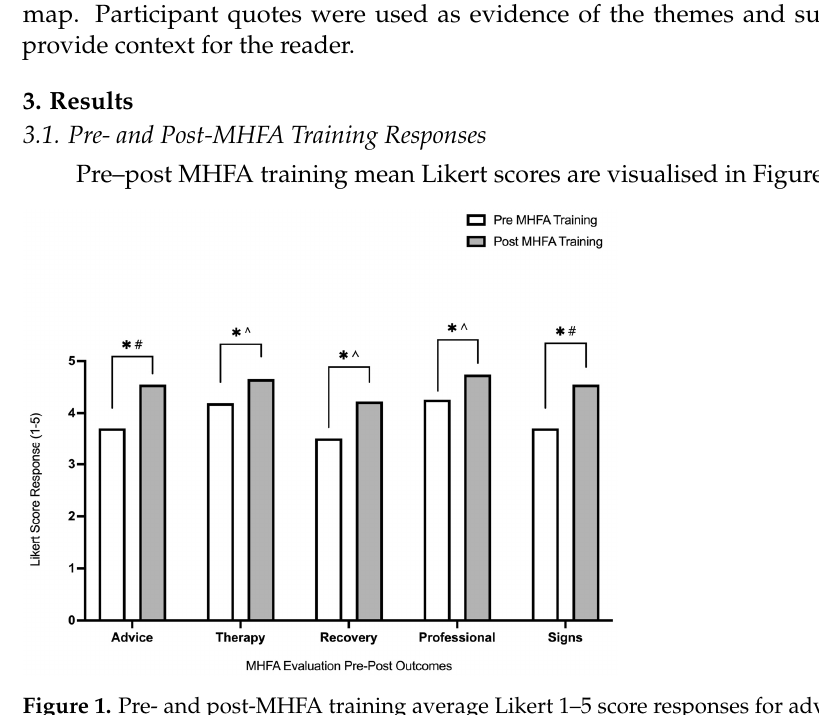
Figure 1. Pre- and post-MHFA training average Likert 1–5 score responses for advice, therapy, recov- ery, professional and signs and symptom categories. Likert scale response options: 1 = strongly dis- agree, 2 = disagree, 3 = unsure, 4 = agree, 5 = strongly agree. * = p < 0.01; # = large ES; ˆ = moderate